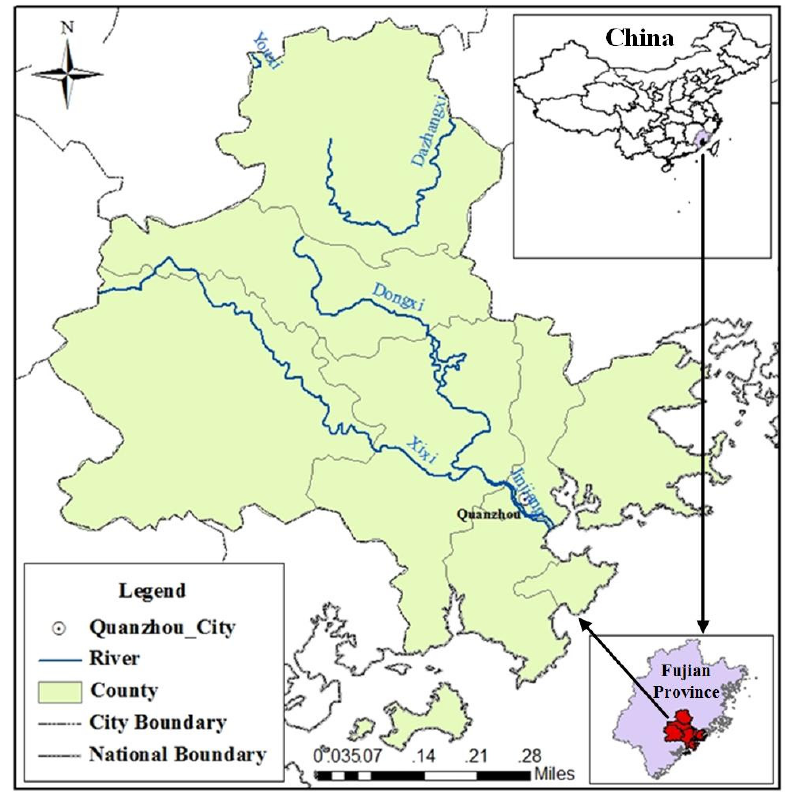
Figure 1. Location of Quanzhou in China.